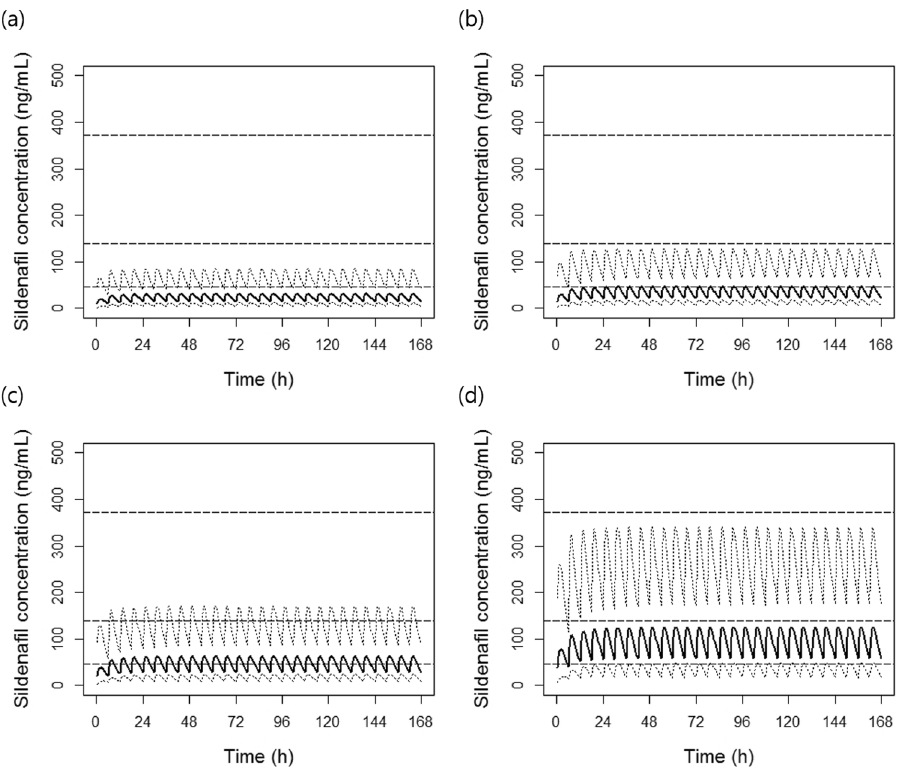
Figure 4. Simulated sildenafil concentration–time profiles after multiple administrations of sildenafil every 6 h: ( a ) 0.5 mg/kg; ( b ) 0.75 mg/kg; ( c ) 1 mg/kg; and ( d ) 2 mg/kg. The solid lines represent the 50 th percentiles, and the dotted lines represent the 5th and 95th percentiles of the simulated data. The dashed lines represent the therapeutic exposure references for C max : 47, 140, and 373 ng/mL are expected to inhibit type 5 phosphodiesterase activity in vitro by approximately 53%, 77%, and 90%, respectively 14 .